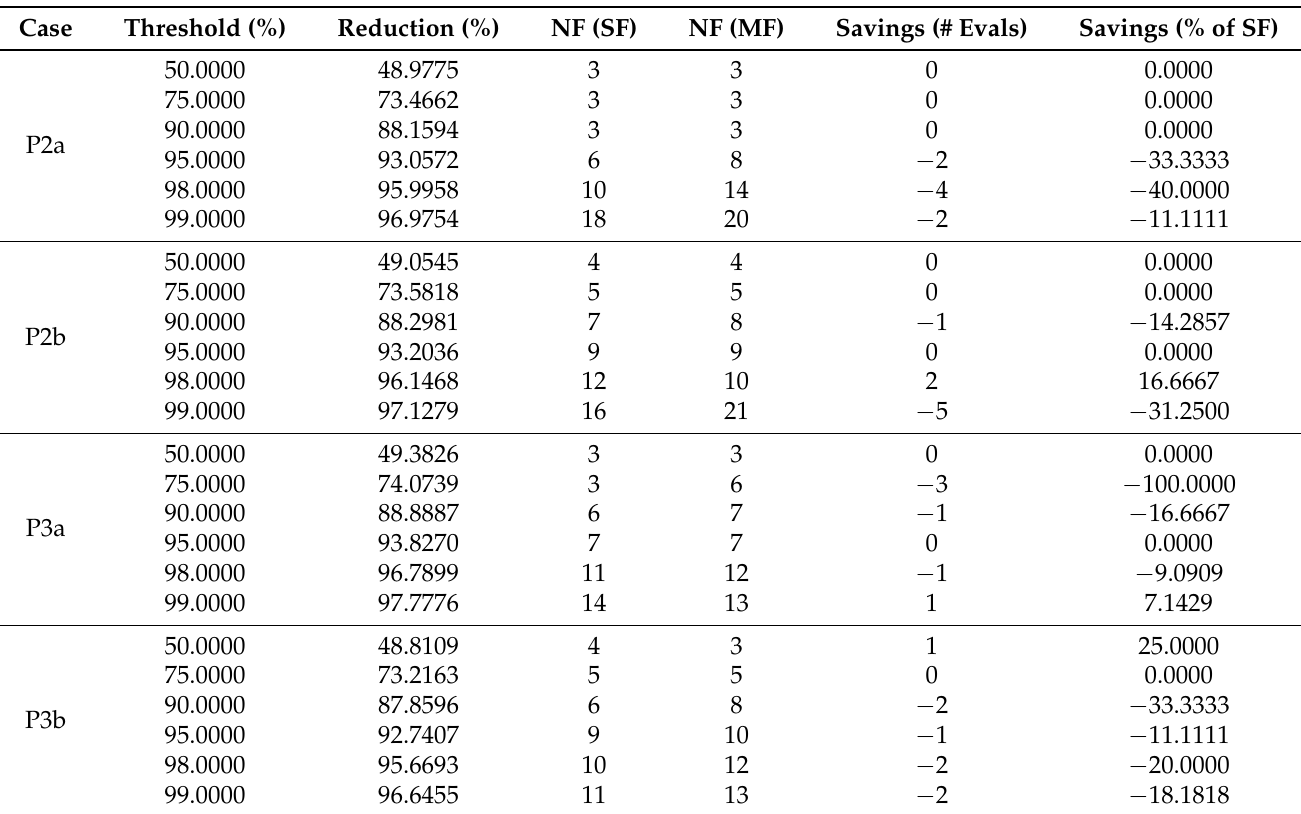
Table 10. Cost summary for optimization cases including structural